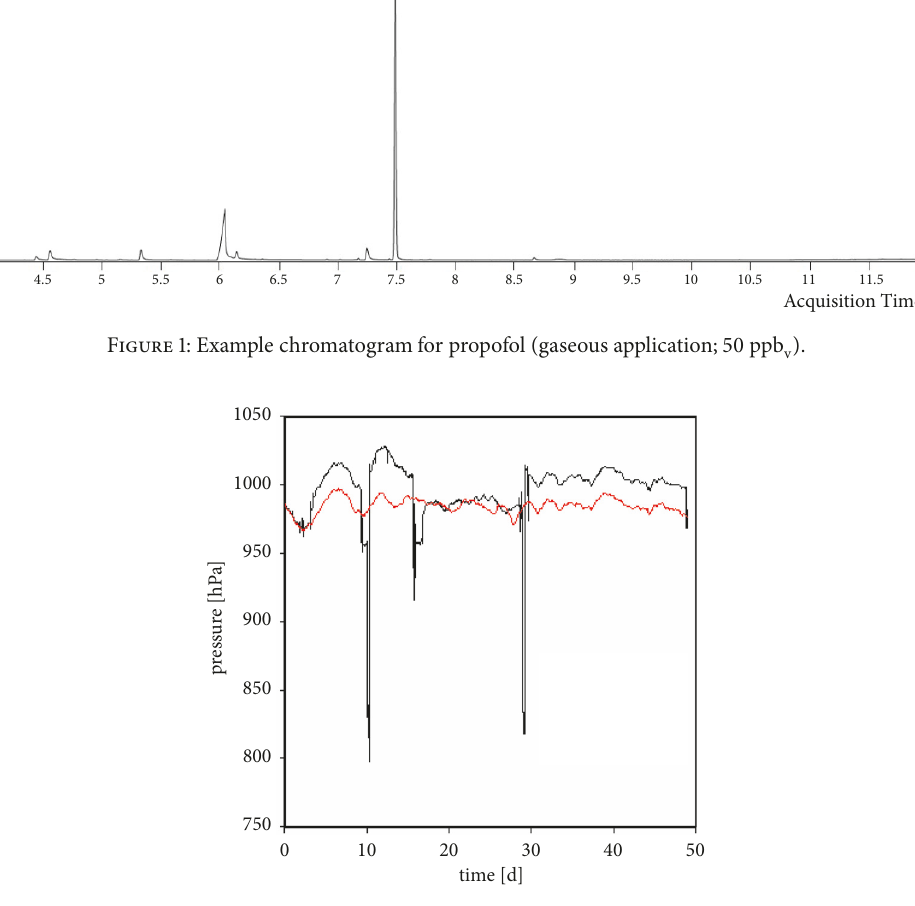
Figure 2: Pressure course for the stored samples (red line) and the mailed samples (black